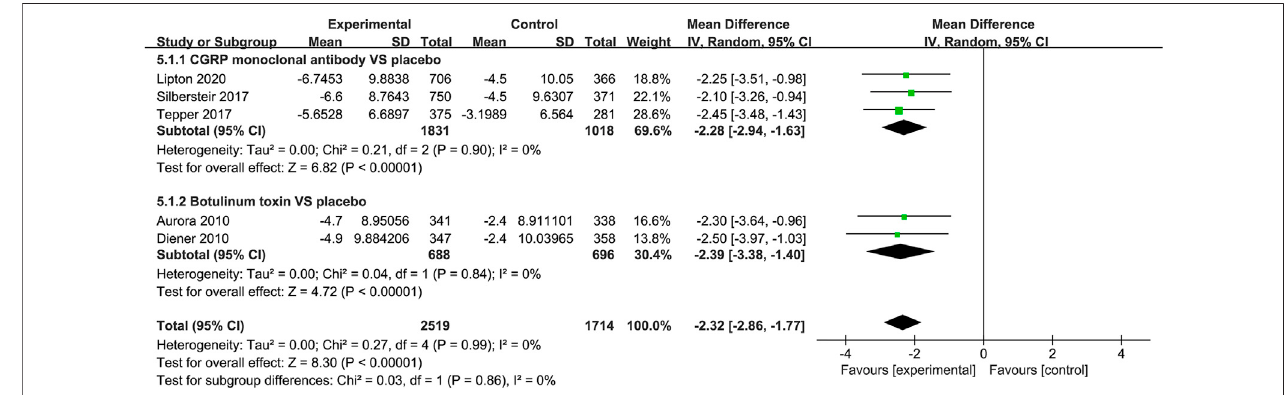
FIGURE 7 | Pooled weighted mean differences of change in HIT-6 score in the treatment group compared with placebo; diamond indicates the estimated relative risk with 95% con fi dence interval for the pooled patients.